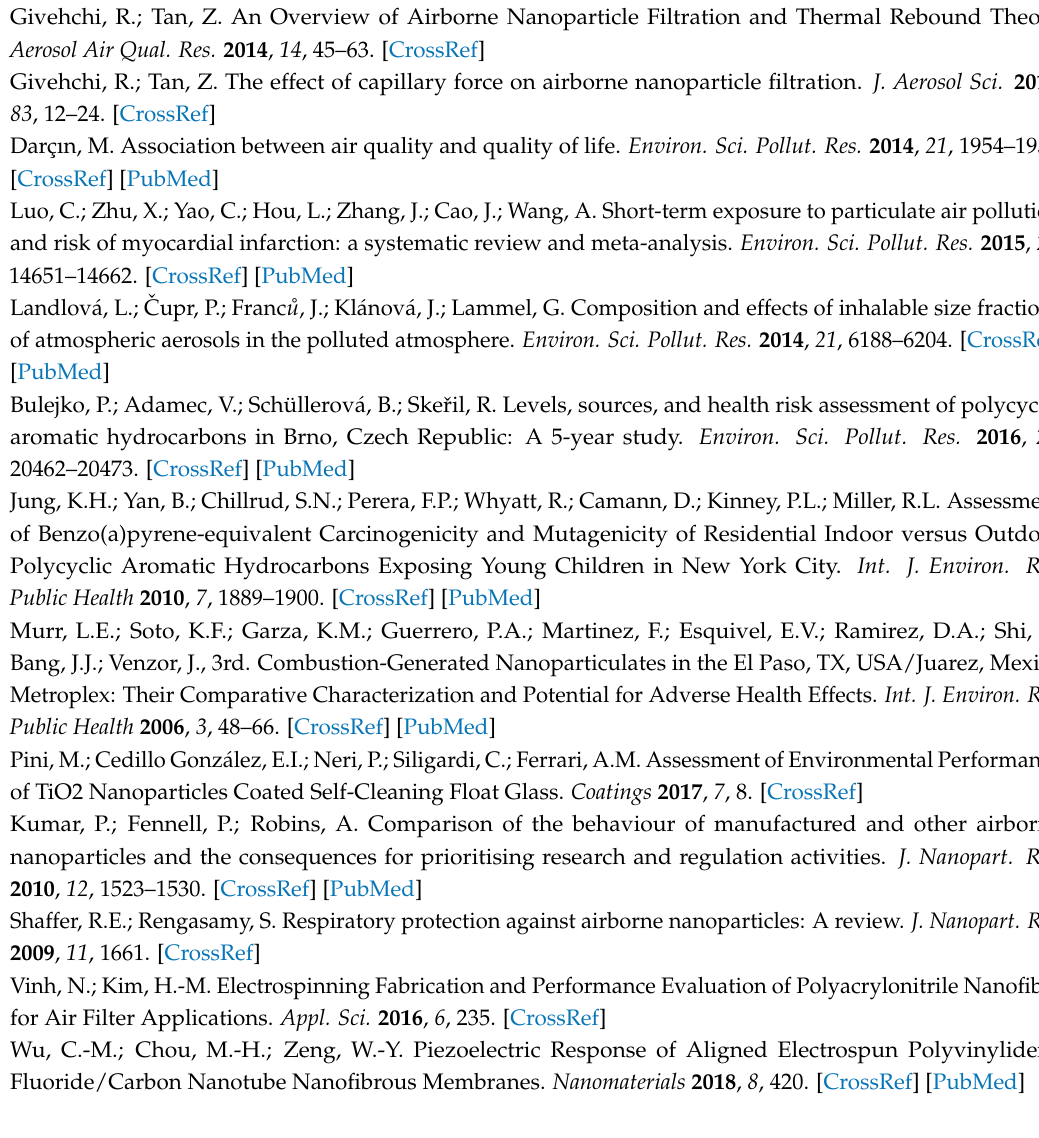
Figure S1: SCE due to inertial impaction based on model of Stechkina et al. (a), Landahl and Herman (b), Fuchs (c), Gougeon et al. (d), Suneja and Lee (e), Friedlander (f), Zhu et al. (g) and Illias and Douglas (h), Figure S2: Comparison of impaction efficiency based on different models and airflow velocity of 5 cm/s (a) and 20 cm/s (b), Figure S3: Collection efficiency due to interception mechanism based on Langmuir model for different airflow velocities (a) and a comparison of SCE due to interception based on models developed by various researchers (b), Figure S4: SCE due to diffusion mechanism based on mathematical models developed by Payet et al. (a), Kirsch and Fuchs (b), Stechkina et al. (c), Lee and Liu (d), Wang et al. (e) and Pich (f), Figure S5; Comparison of SCE due to diffusion mechanism based on different models for an airflow velocity of 5 cm/s (a) and 20 cm/s (b). Funding: The work was carried out within the framework of the project No. LO1202 “NETME Centre PLUS” and No. LO1418 “Progressive development of Membrane Innovation Centre” supported by the program NPU I Ministry of Education Youth and Sports of the Czech Republic, using the infrastructure Membrane Innovation